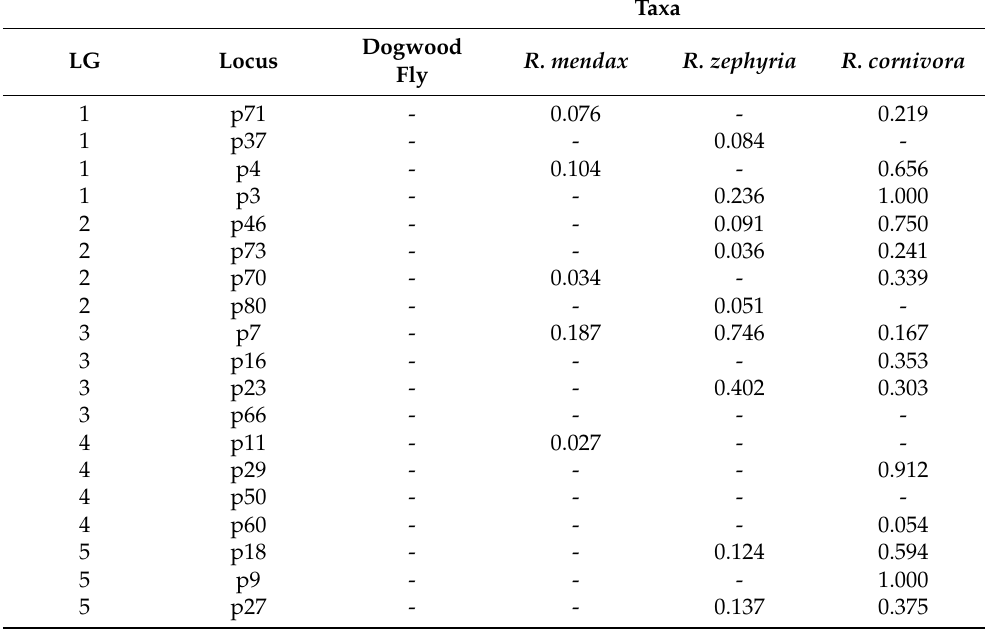
Table 2. Frequency of private alleles for 19 microsatellites in four species-level taxa in the RPSC relative to R. pomonella . Frequency values represent the sum of allele frequencies for individual private fragment length polymorphism across all individuals in each taxon. For in-group taxa, designated private alleles were detected in more than one population of that taxon and absent in all other populations. This requirement of ≥ 2 populations could not be met in R. cornivora , due to a single population being